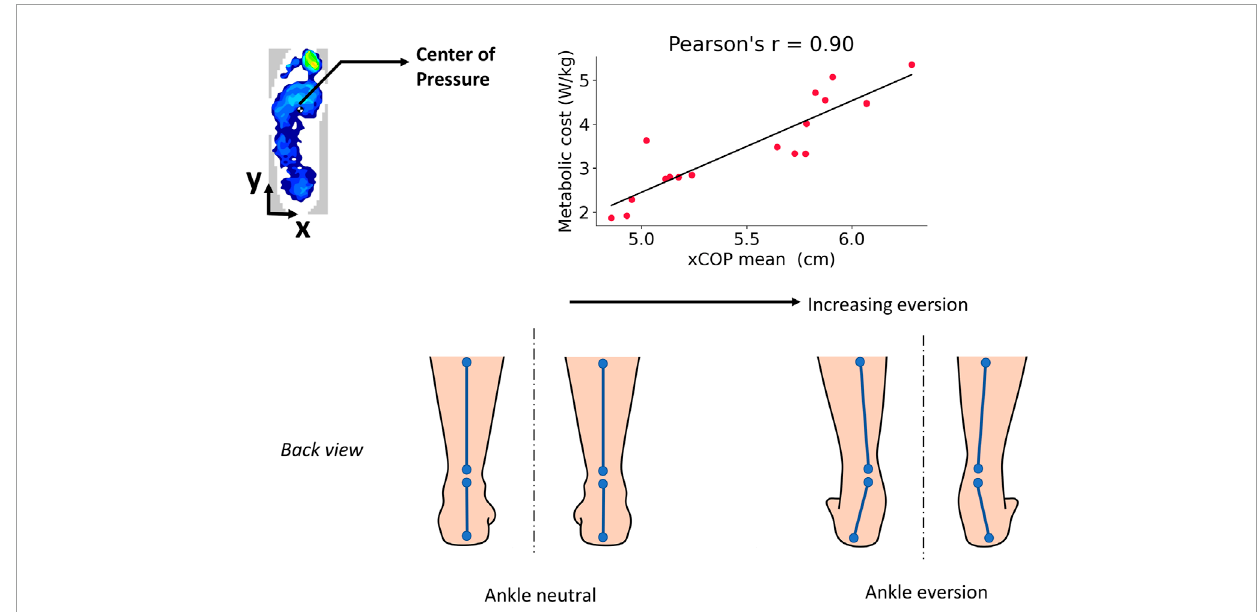
FIGURE 7 Interpretation of the main results. Increasing ankle eversion (outward ankle roll) was associated with higher metabolic costs, indicating a sub-optimal squatting strategy at those assistive torques of the exoskeleton.